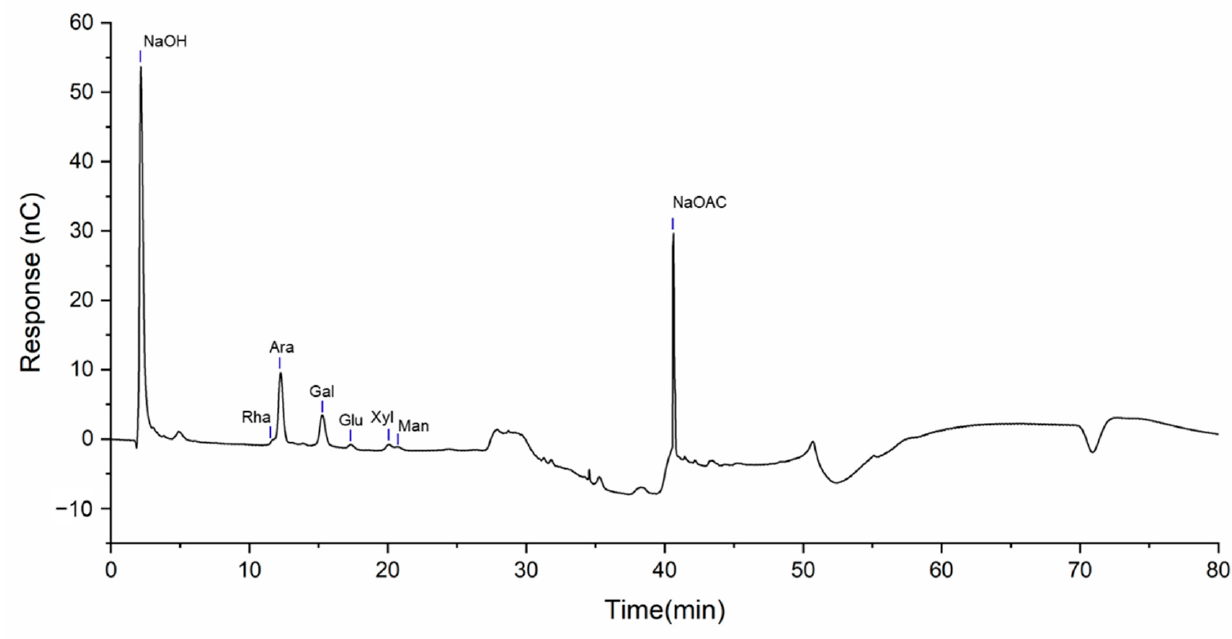
Figure 2. Ion chromatogram of LBP.